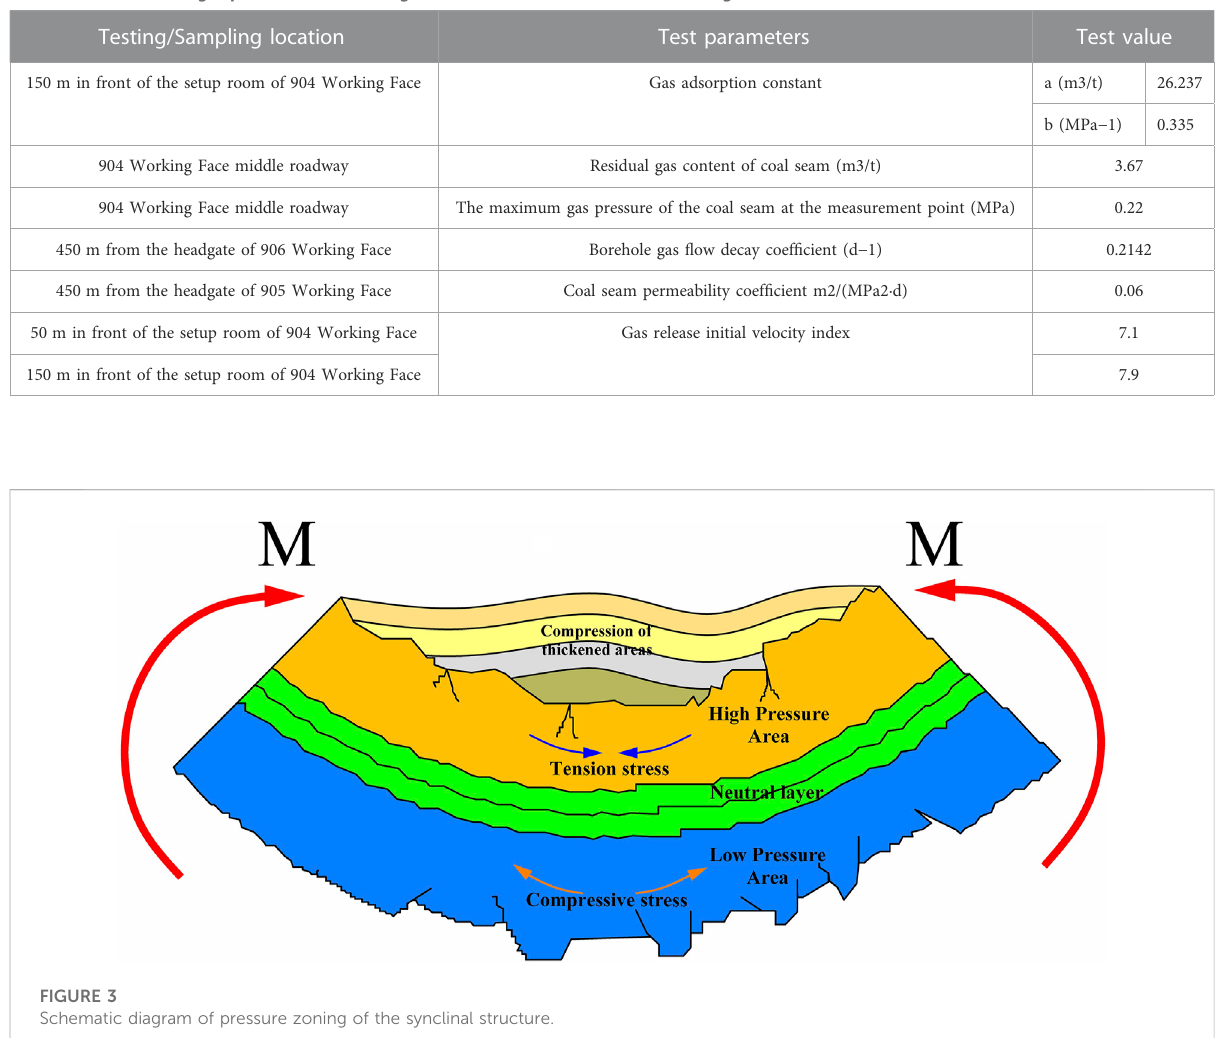
TABLE 1 Test results of gas parameters at working face of nine# Coal Seam in West Mining Area 2.